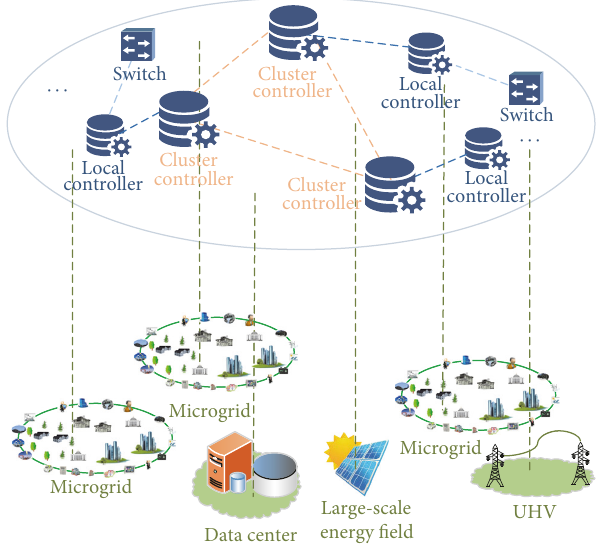
Figure 4: SDN-enabled global grid level communication network